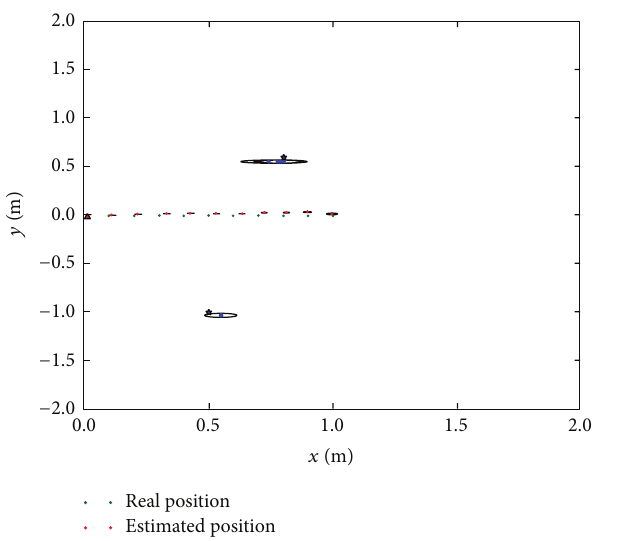
Figure 8: The simulation motion result of Robot SLAM with closed- loop controller.